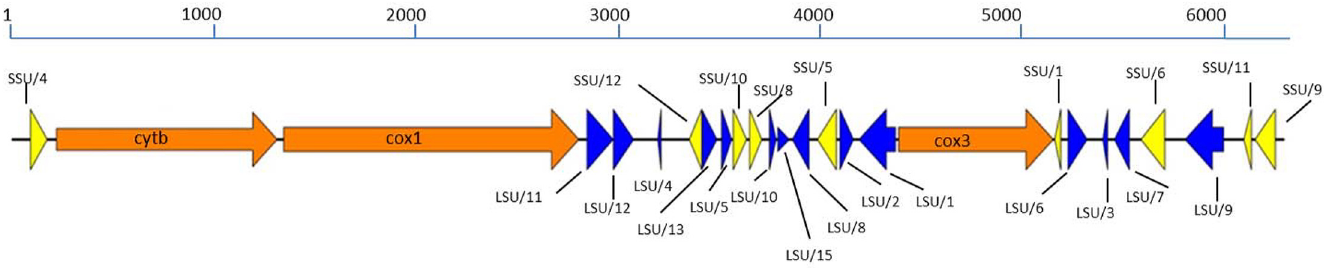
Fig 2. Gene arrangement of the C . cayetanensis mt genome. Predicted genes on the Cyclospora mitochondrial genomes were derived based on ClustalW alignment with the Eimeria gallopavonis (KJ608417). Orange indicates coding genes, blue indicates fragments of LSU rRNA, and yellow indicates fragments of SSU rRNA. Transcriptional direction is indicated by arrowed